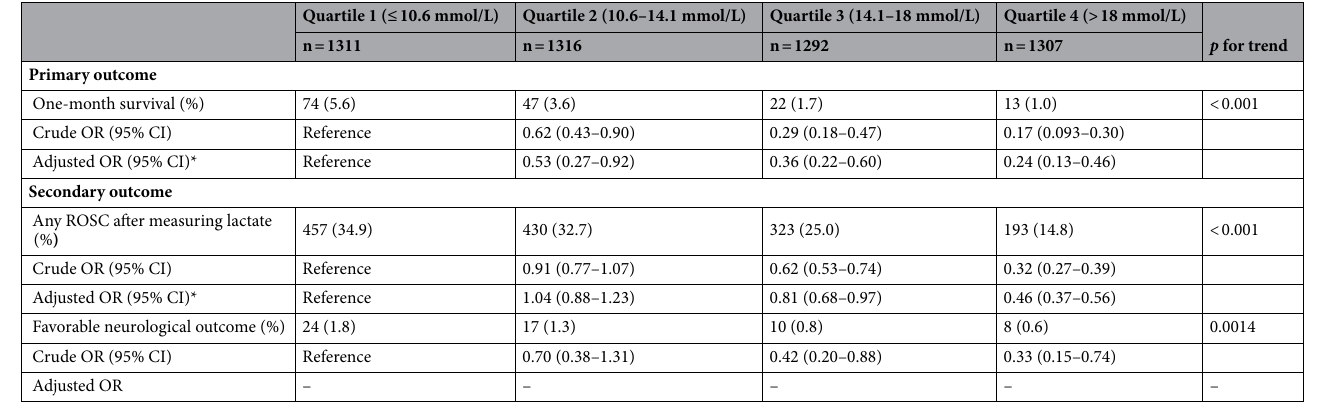
Table 2. Outcomes after OHCA by serum lactate level measured during cardiac arrest at hospital arrival. OHCA out-of-hospital cardiac arrest, ROSC return of spontaneous circulation, OR odds ratio, CI confidence interval. *Adjusted for age, sex, bystander witness, bystander CPR, first documented rhythm at the scene, prehospital advanced airway management, prehospital adrenaline administration, and time from EMS call to lactate